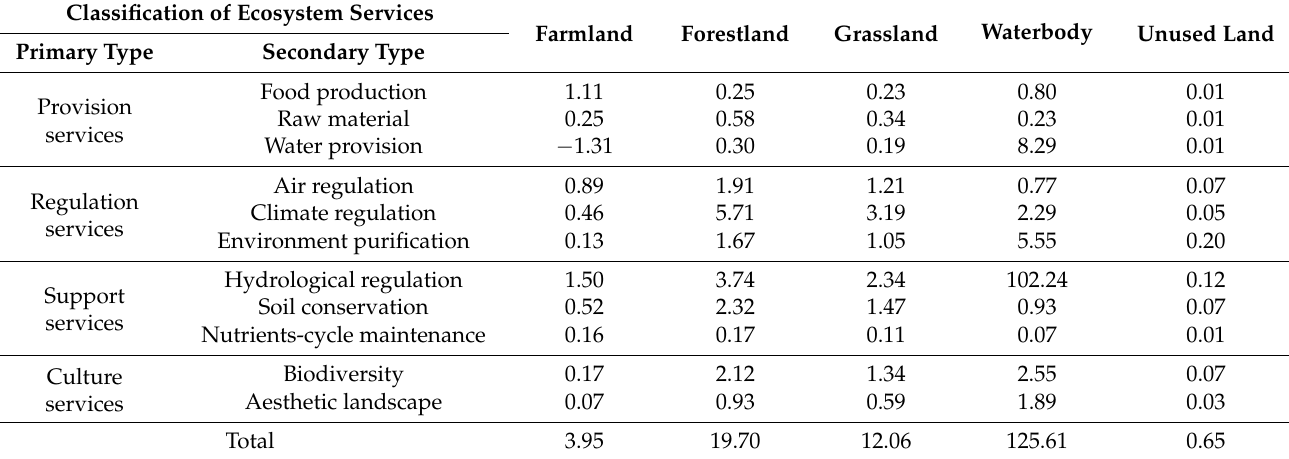
Table 1. Ecosystem services equivalent factors in Nujiang